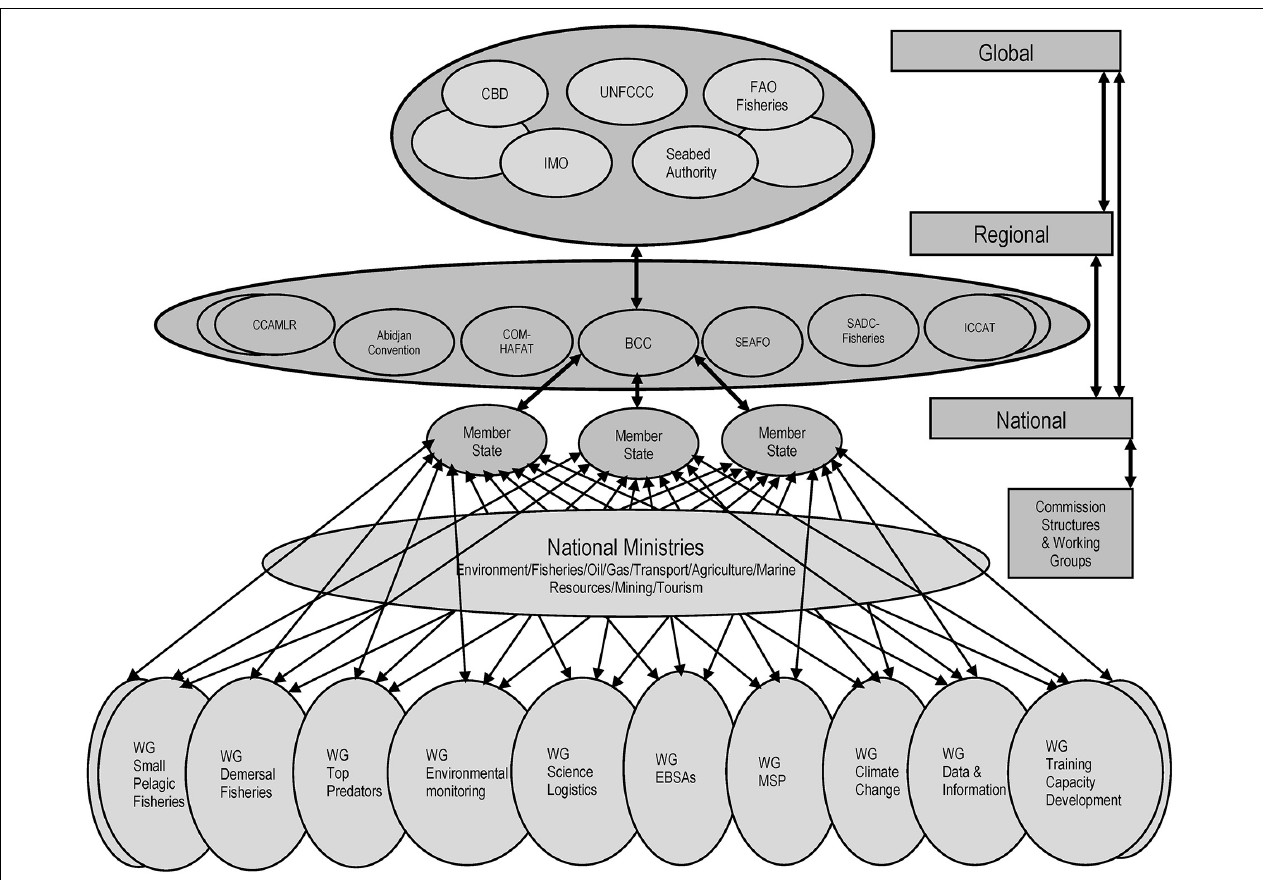
FIGURE 3 | Schematic representation of global-regional-national governance architecture around the BCC Commission adapted from Mahon and Fanning (2019b). Not all global and regional forums and their linkages are illustrated.